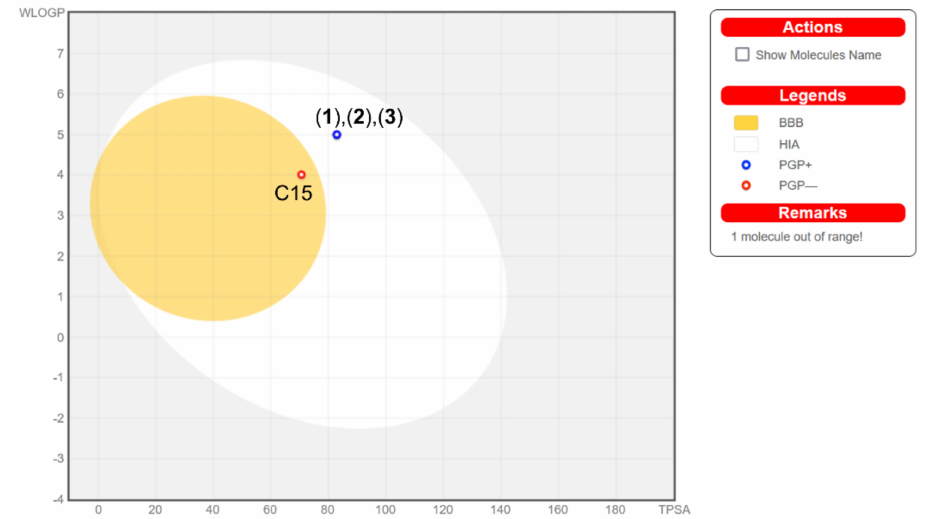
Figure 8. BOILED-Egg diagram for C15 and complexes.